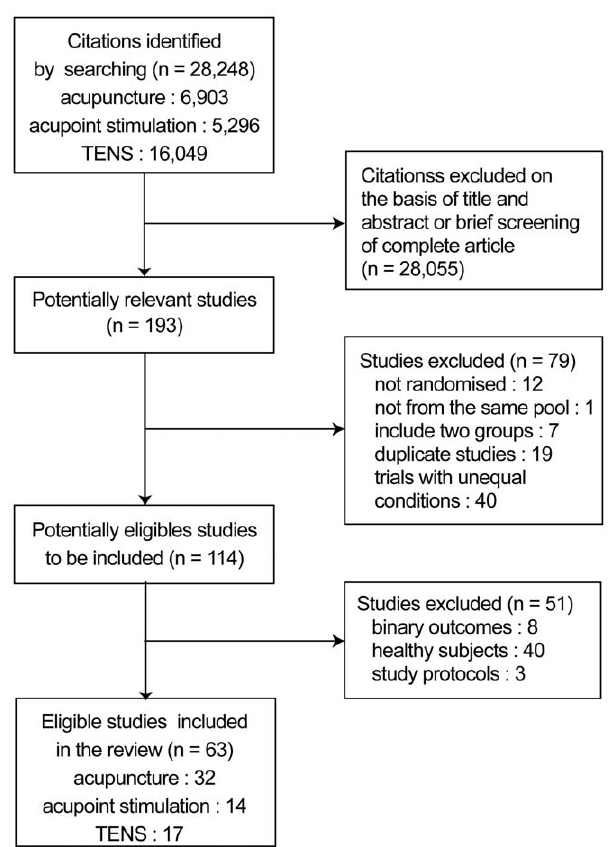
Figure 1. Study flow diagram.